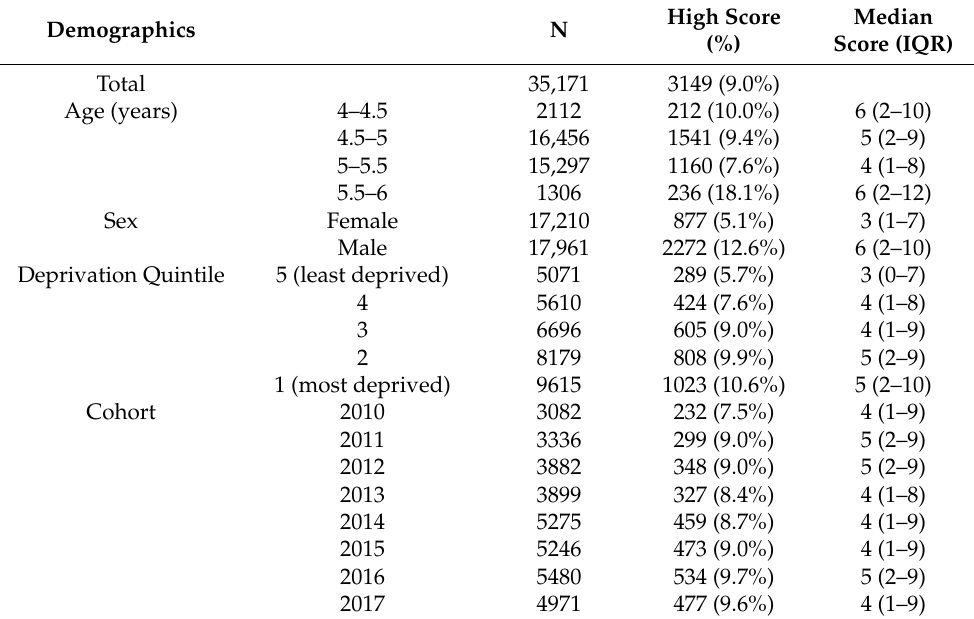
Table 1. Baseline